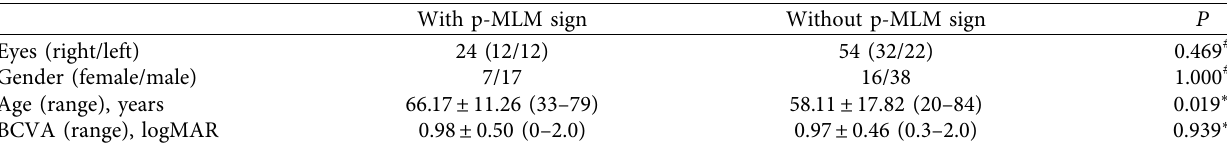
Figure 1: OCTdisplayed combined PAMM and p-MLM in one case with RVO. Pink arrows indicate skip PAMM lesions around the central macula. Yellow arrows indicate a continuous hyperreflective line being referred to as p-MLM sign on both sides of the fovea. Table 2: Clinical characteristics of PAMM eyes with and without p-MLM sign.